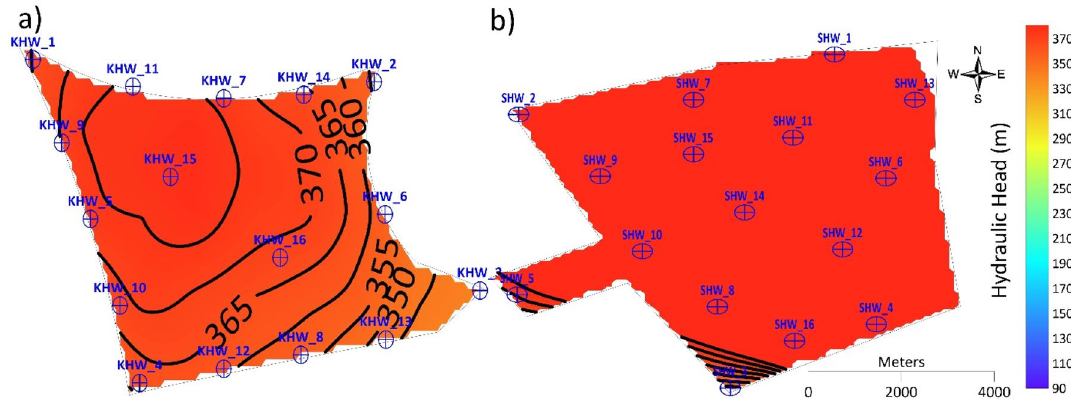
Figure 10. Simulated hydraulic head in 2030 for Scenario 5 at ( a ) Al-Khrair and ( b ) Al-Shuwaib sites.